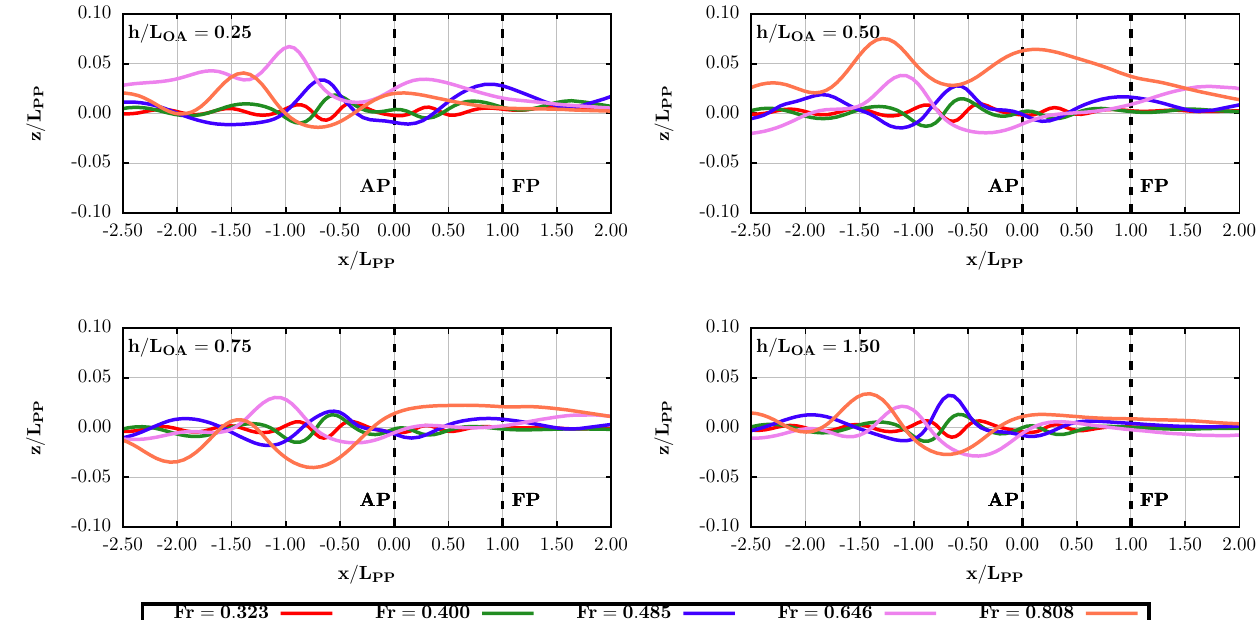
Figure 13. Longitudinal wave cuts at the centerline of the catamaran at different water